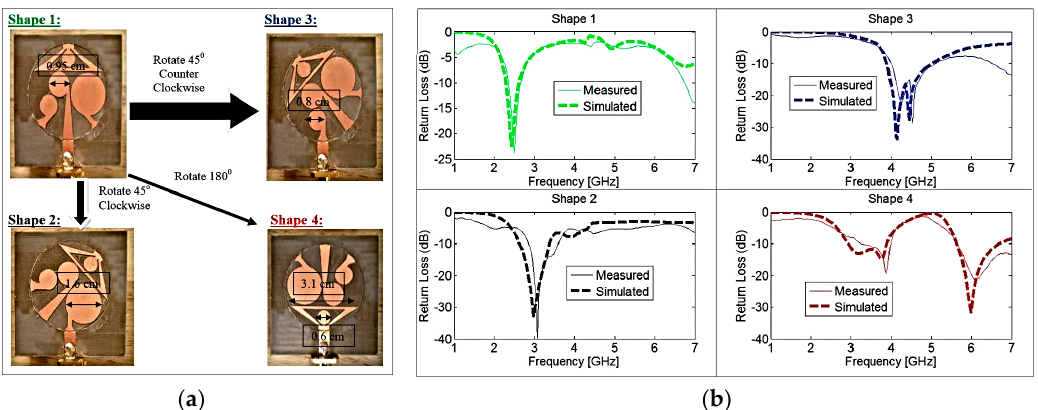
Figure 8. ( a ) Different configurations and ( b ) measured/simulated return losses of the antenna (redrawn from [60]).